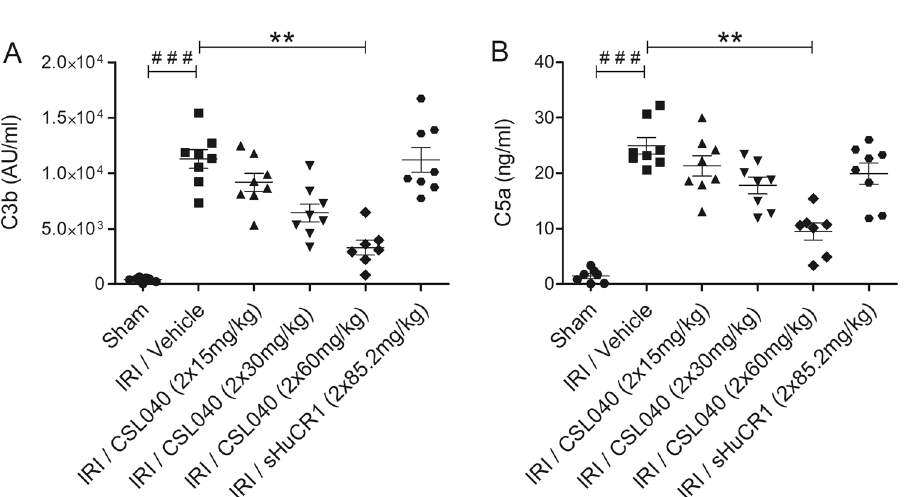
Figure 4. Attenuation of IR-induced systemic complement activation products C3b and C5a by CSL040 treatment. Plasma samples collected 24 h after reperfusion were analysed for ( A ) C3b, and ( B ) C5a by ELISA. Significance was tested using Mann–Whitney U test ( ### p < 0.001 for sham vs. IRI/vehicle), and One-way ANOVA Kruskal–Wallis and Dunn multiple comparisons test (**p < 0.01 for IRI/vehicle vs. all treatments). The data shown are mean ± SEM (n = 7–8 per